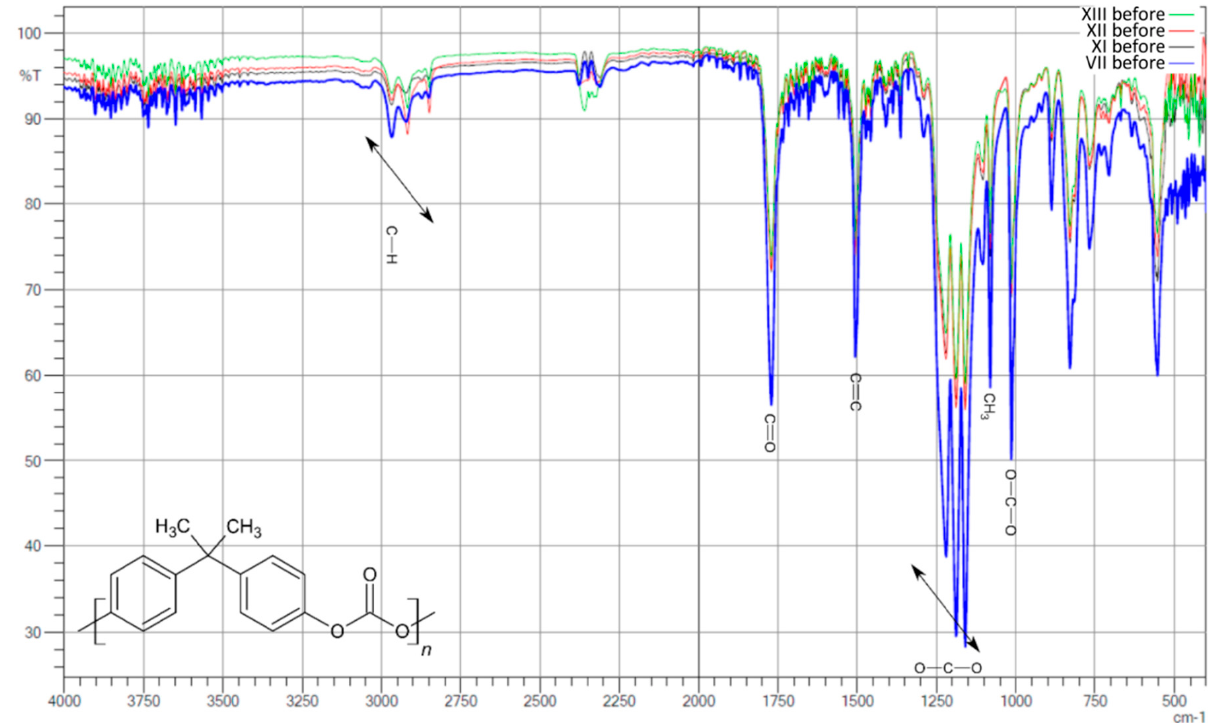
Figure 4 . Compilation of IR spectra after aging for samples I, II, III, IV, V, VI, and VII .